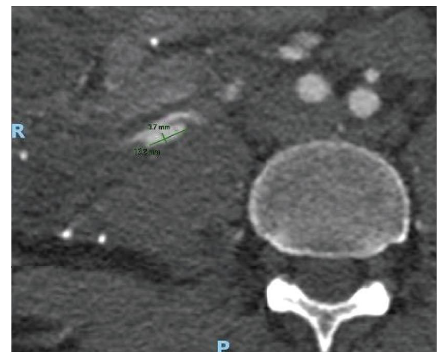
Figure 2: Contrast computed tomography scan of the abdomen showing one of the two pseudoaneurysms of the superior artery of the Y -graft.